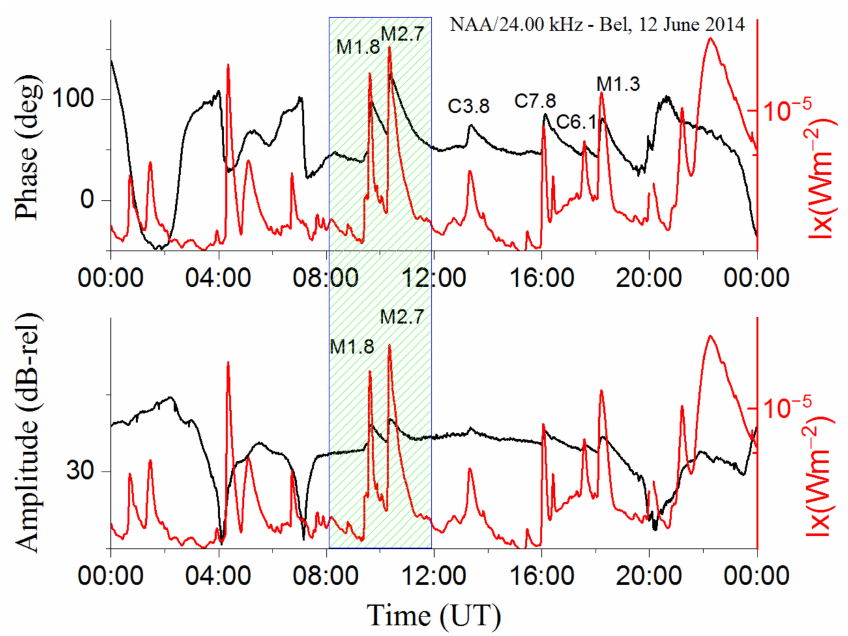
Figure 5. X-ray flux, amplitude, and phase of NAA signal during strong successive flares on 12 June 2014. (Lower panel) Amplitude and X-ray flux variation; (Upper panel) phase and X-ray flux variation.